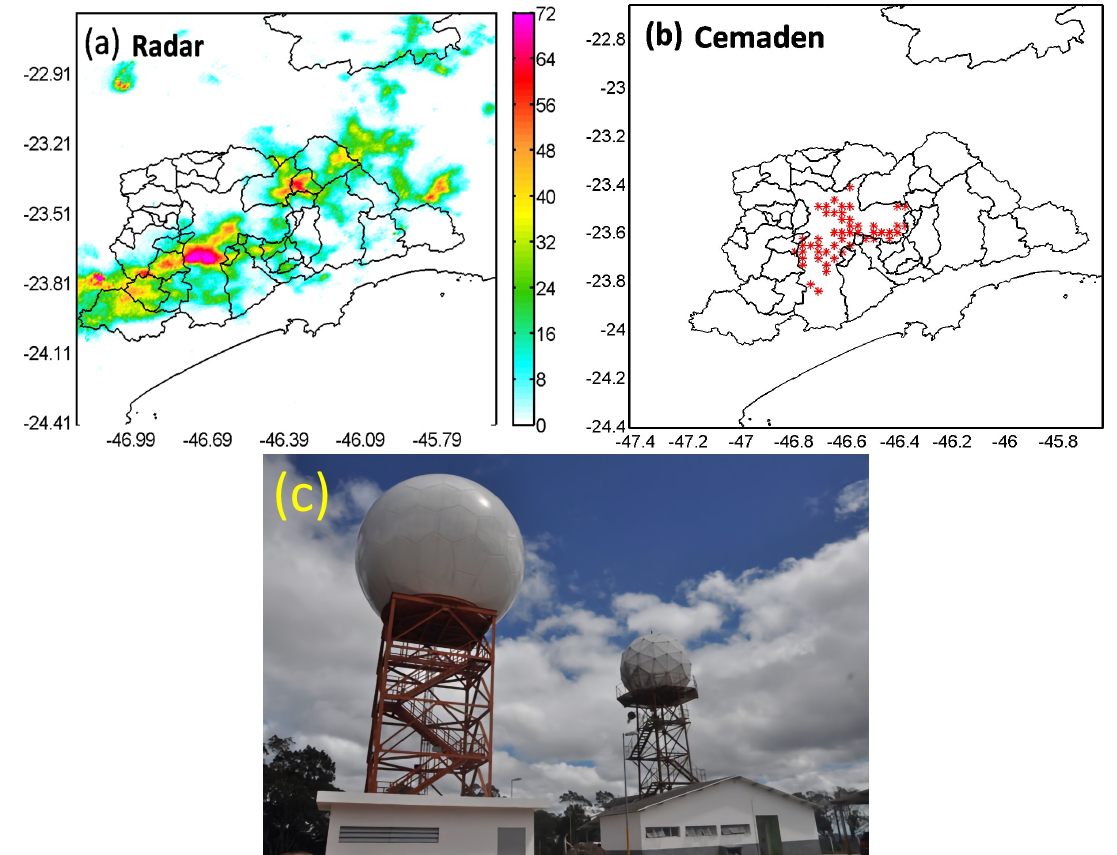
Figure 6. ( a ) The spatial distribution of the accumulated precipitation (mm) estimated from the weather radar of São Paulo between 17 UTC (14 LT) and 21 UTC (18 LT). ( b ) Geographic locations of automatic pluviometric stations maintained by Center for Monitoring and Alerts of Natural Disasters (CEMADEN) in the MASP [54]. ( c ) The São Paulo weather radar (SPWR) located at 23 ◦ 36 (cid:48) 00 (cid:48)(cid:48) S, 45 ◦ 58 (cid:48) 20 (cid:48)(cid:48) W and 916 m. The radar was manufactured by McGill University of Canada and is installed in the Ponte Nova dam located at the headwaters of the Tietê